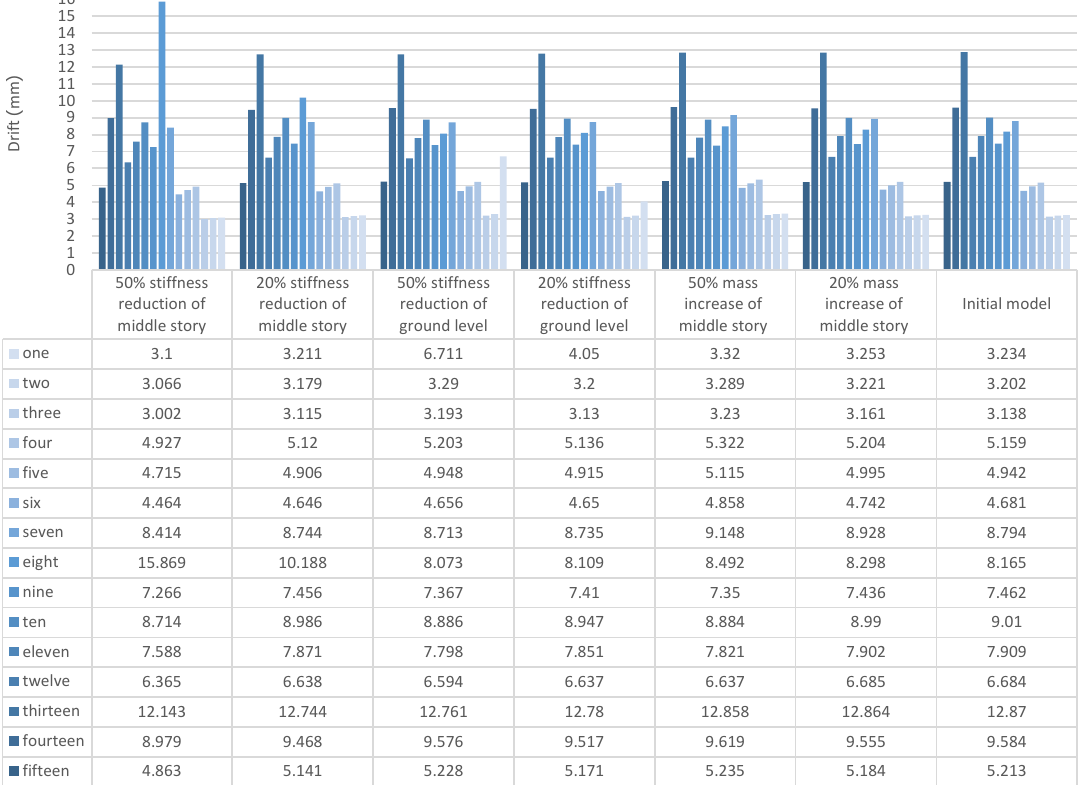
Fig. 13. Drift of 15 story